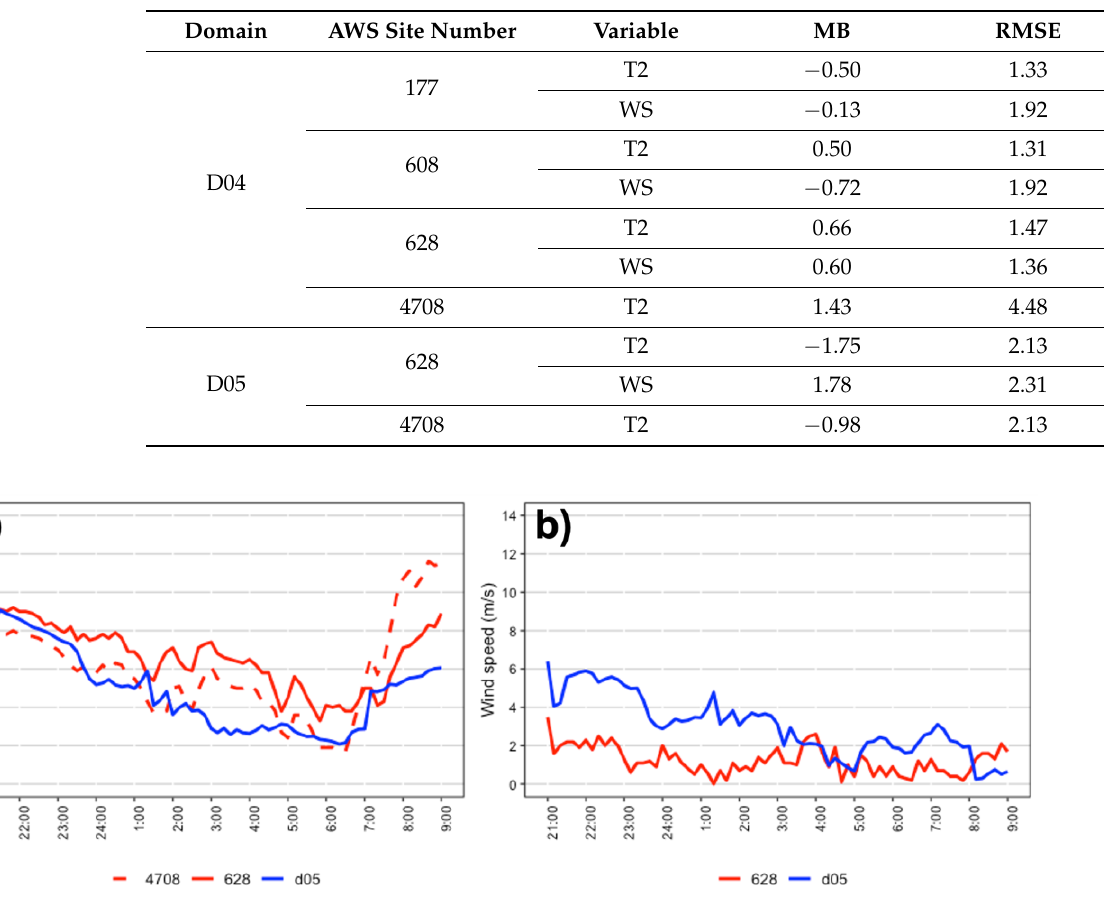
Figure 9. Comparison of time series of observed data at AWS (#4708 and #628) and WRF–LES simulation in domain 5 for Case 1. ( a ) The 2 m air temperature (°C) and ( b ) wind speed (m/s).